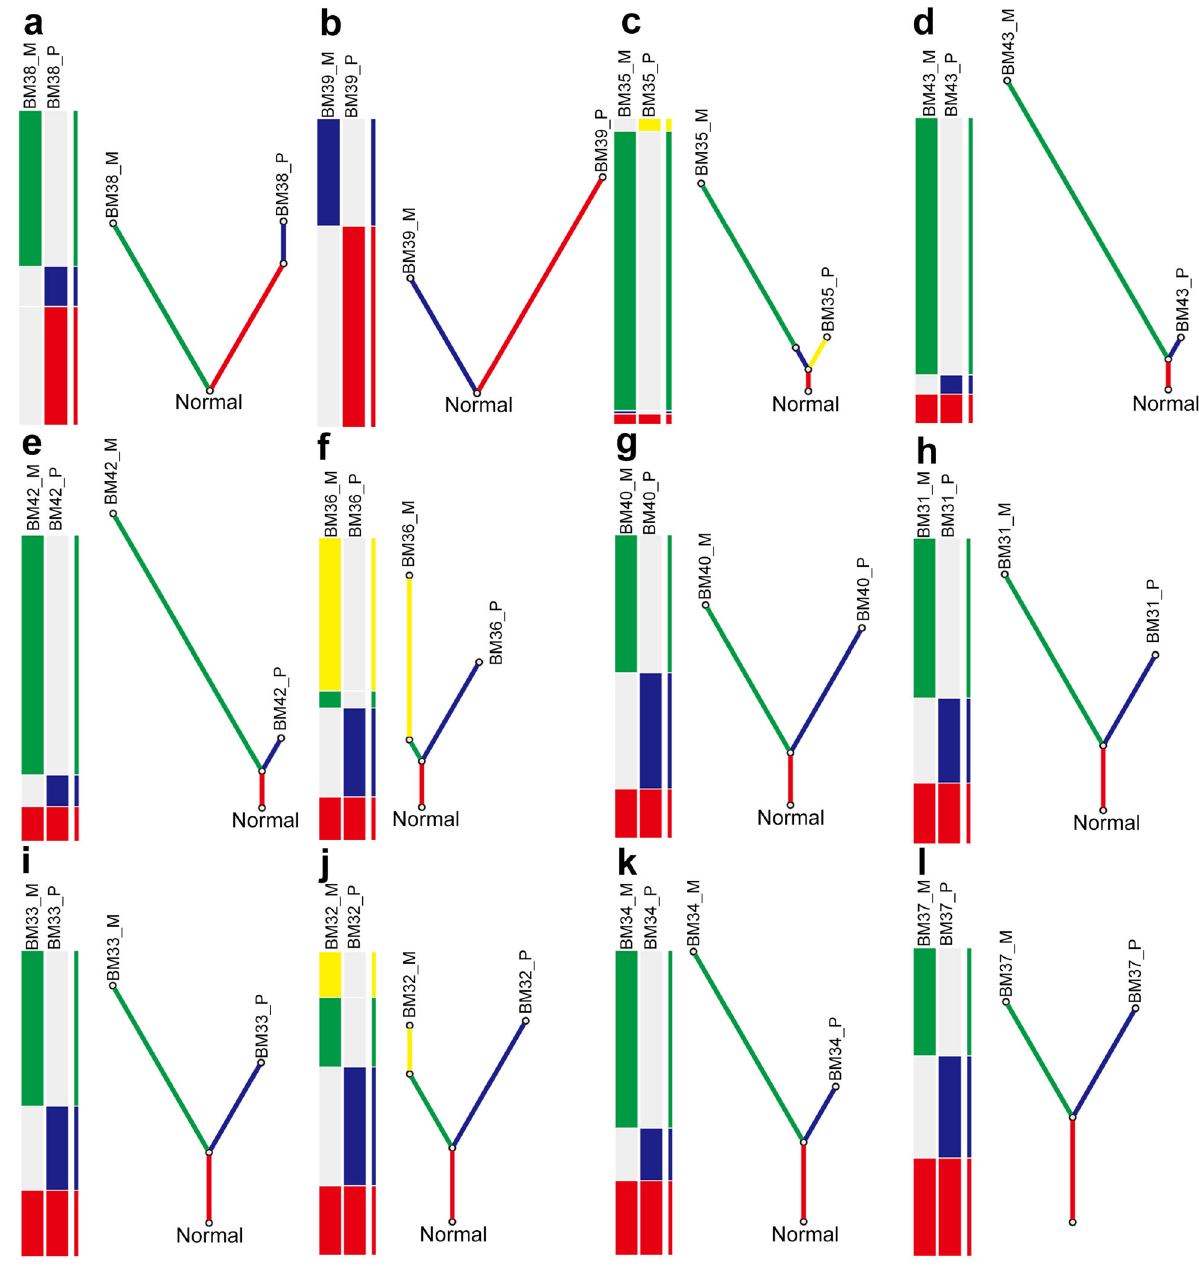
Fig. 3 Phylogenetic analysis of cases with brain metastases. a – l phylogenetic tree of BM38, BM39, BM35, BM43, BM42, BM36, BM40, BM31, BM33, BM32, BM34, and BM37. For each panel, heatplot with different bars represents various distributions of identi fi ed mutations including somatic SNVs and CNVs. Fraction of ubiquitous identi fi ed mutations (trunk) and unique identi fi ed mutations (branch) reveal the phylogenetic relationship of BM_P and BM_M within a single case. BM_P primary lesion, BM_M brain metastatic